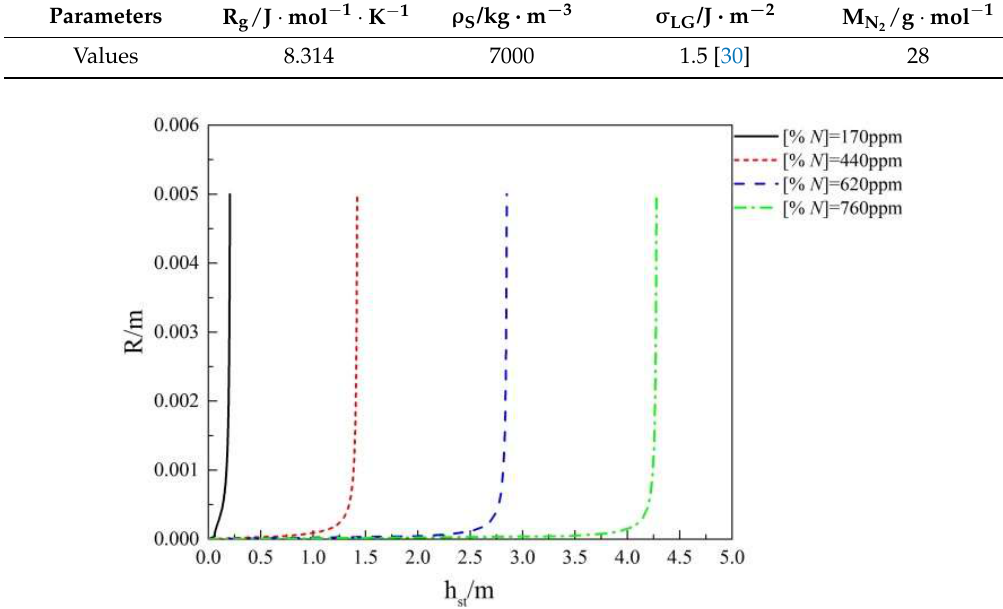
Figure 10. Relationship between the critical nucleation radius of bubbles and the melt depth under different nitrogen content.